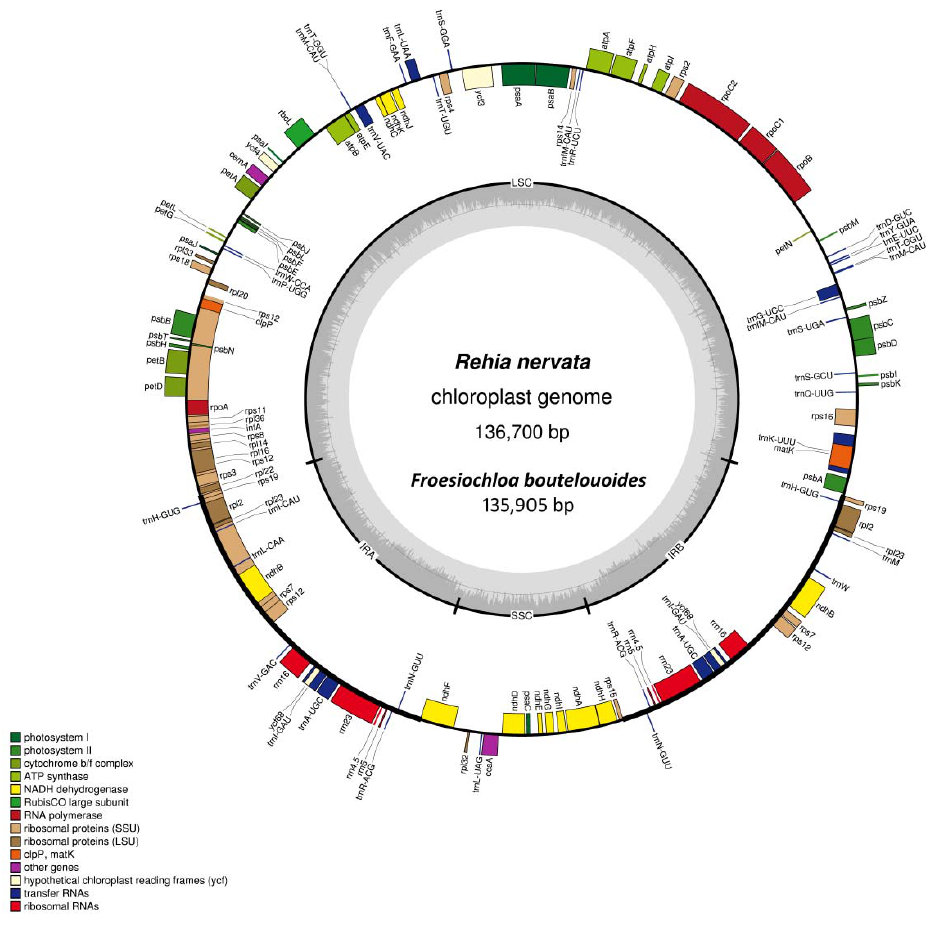
Figure 1. Chloroplast genome map of Rehia nervata . Genes belonging to different functional groups are color coded. Genes drawn outside the circle are transcribed clockwise and those inside are counterclockwise. The darker gray in the inner circle indicates the GC content of the chloroplast genome.